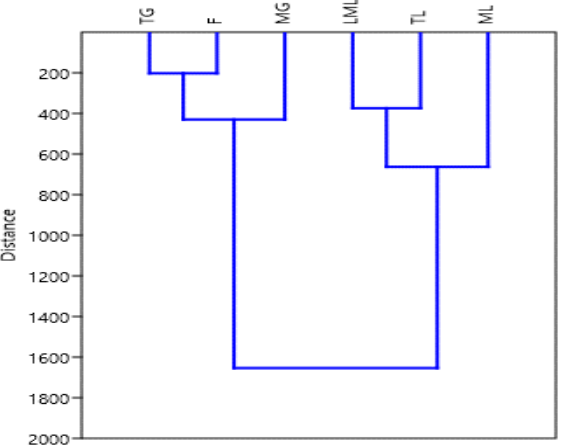
Figure 6. Hierarchical clustering of amaranth plant in different growth stage. TG, tender grains; F, flowers; MG, mature grains; LML, late maturity leaves; TL, tender leaves; ML, mature leaves.